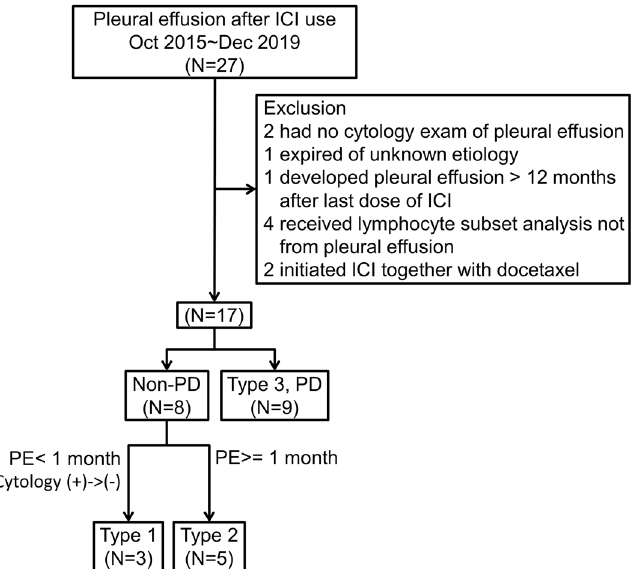
Figure 1. Algorithm for enrollment and follow-up of the study participants. Type 1: rapid growth of pleural effusion within 1 month after immune checkpoint inhibitor use. Malignant cells were found in pleural effusion after the initial treatment but were absent in the following serial thoracenteses. Type 2: slow growth of pleural effusion developed more than one month after immune checkpoint inhibitor use. Type 3: pleural effusion due to disease progression. ICI: immune checkpoint inhibitor, PD: disease progression, PE: pleural